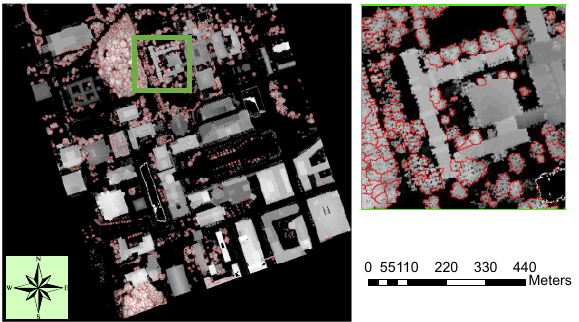
Figure 3. Individual tree crowns delineated from the VHR imagery and LiDAR CHM data overlaid with LiDAR CHM in Site